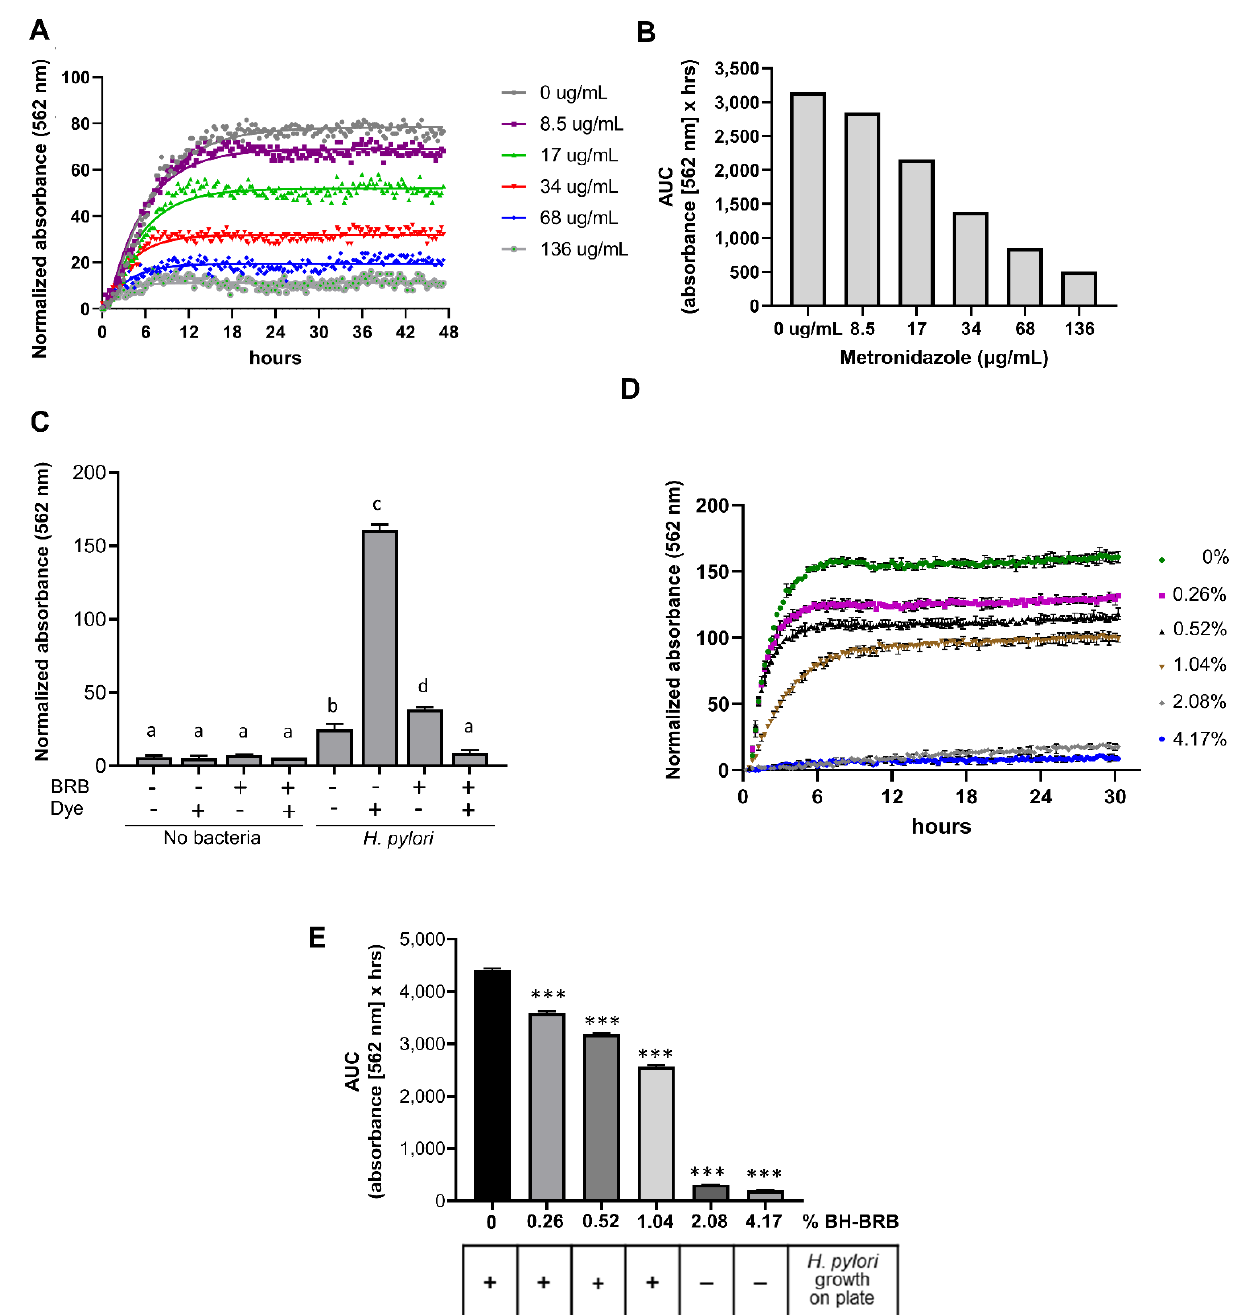
Figure 3. Concentration-dependent growth suppression of H. pylori by metronidazole and black raspberries measured using the OmniLog ® assay. ( A ) Absorbance of H. pylori strain 60190 measured over time in the presence of different concentrations of metronidazole, one representative experiment of three experiments is shown. ( B ) Area under the curve (AUC) values for the experiment shown in ( A ). ( C ) Endpoint absorbance values measured by the OmniLog ® after 48 h of culture with and without H. pylori strain PMSS1, 8% BH-BRB powder, and/or tetrazolium dye. One representative experiment of three independent experiments with triplicate wells is shown. One-way ANOVA; different letters indicate statistically significant differences at p ≤ 0.001. ( D ) Absorbance of H. pylori cultures measured over time in the presence of different concentrations of BH-BRB powder. Mean ± SD of triplicate wells, representative of one out of three experiments. ( E ) AUC values for the experiment shown in ( D ). One-way ANOVA; *** indicates statistically significant differences from the untreated control at p ≤ 0.001. Bottom panel: matched H. pylori growth data on plates, representative of four independent experiments.